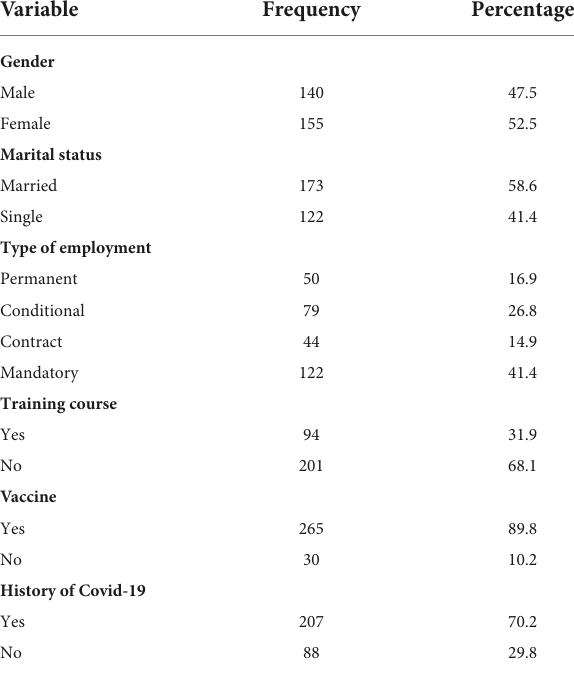
TABLE 1 Distribution of the participants according to demographic and some COVID-19 related